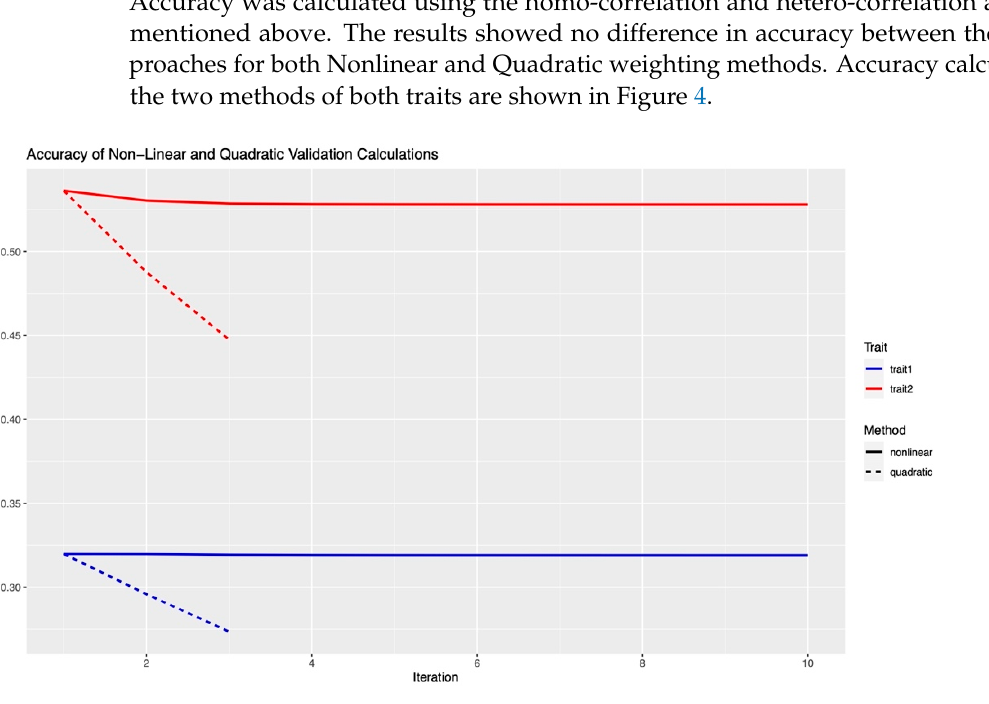
Figure 4. Graph showing the accuracy calculations for the Nonlinear “A” and Quadratic Methods. Blue lines represent Trait One calculations for Nonlinear “A” (solid line) and Quadratic method (dotted line). Red lines represent Trait Two calculations for Nonlinear “A” (solid line) and Quadratic method (dotted line). The x-axis shows the iteration, ten for Nonlinear “A” and three for Quadratic, and the y-axis shows the accuracy calculated by correlation.